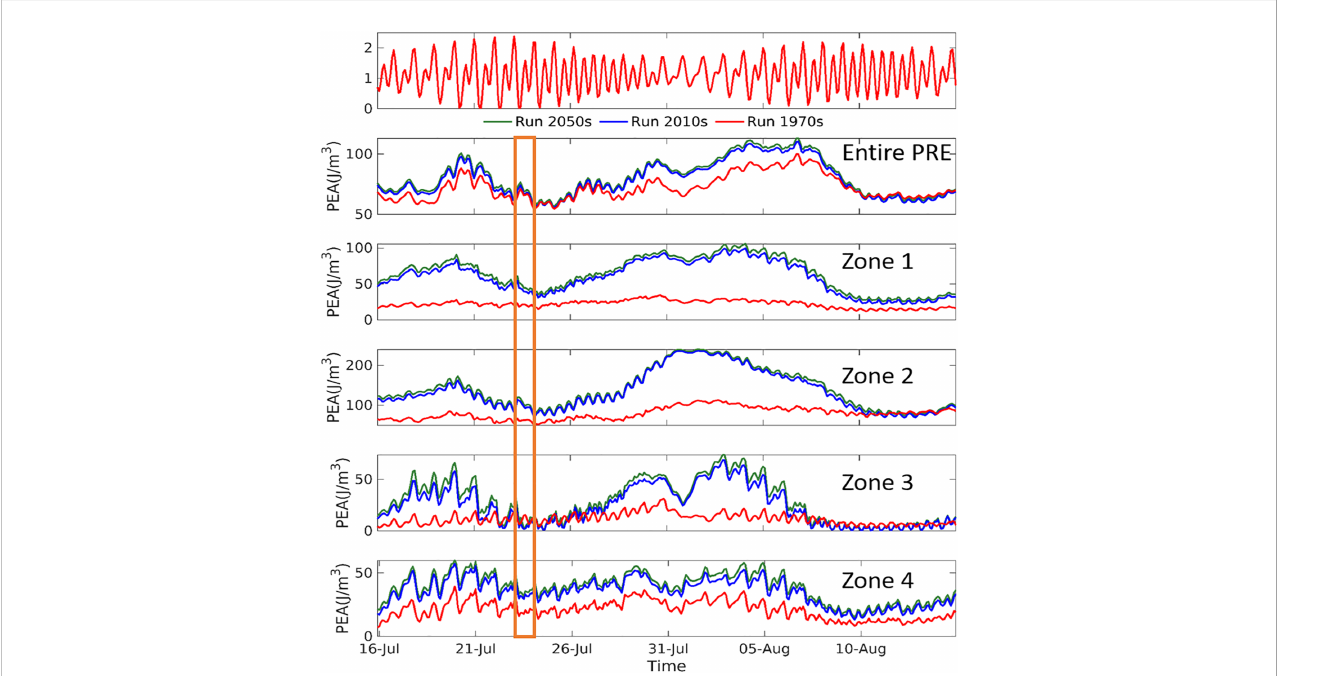
FIGURE 5 Potential energy anomaly ( j ) in different sub-regions in the three scenarios from 16 July to 15 August. Duration of the typhoon Roke is marked by the orange